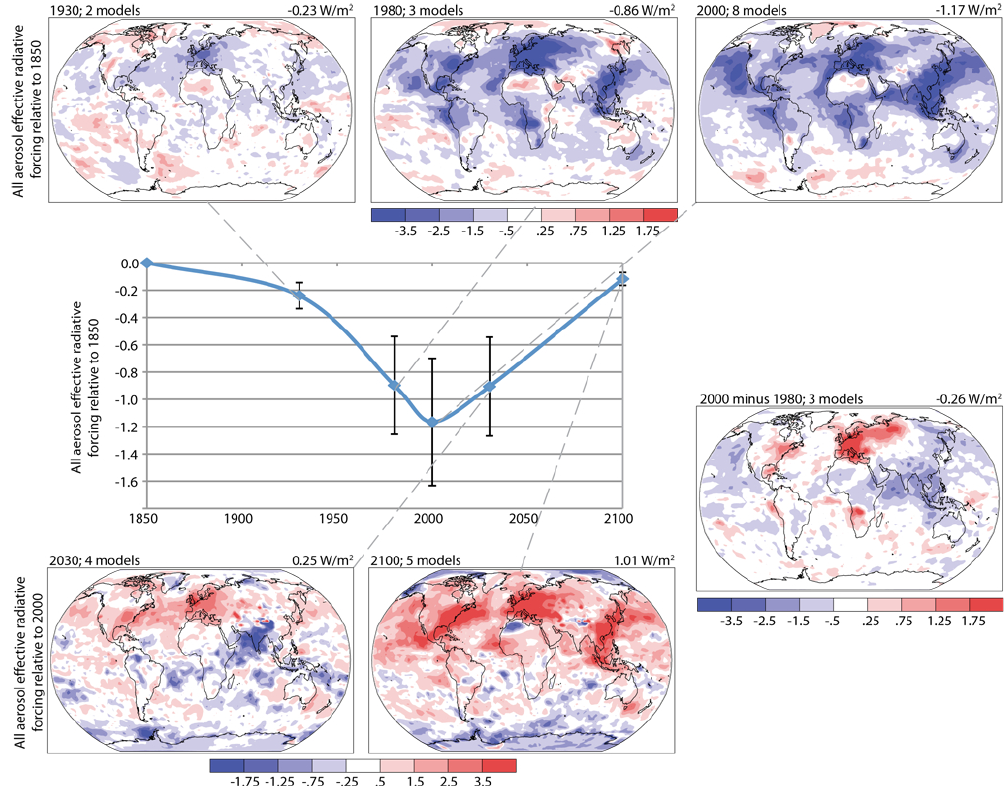
Fig. 18. Spatial patterns of all aerosol ERF for 1930, 1980 and 2000 relative to 1850, for 2030 and 2100 under RCP8.5 relative to 2000 and for 2000 relative to 1980. The timeseries shows global mean values all relative to 1850. All ERF values other than at 2000 are based on fractional changes relative to 2000 in models with data available at both times, and uncertainty is assigned as the relative uncertainty at 2000 (1.65 standard deviation as 5–95% confidence